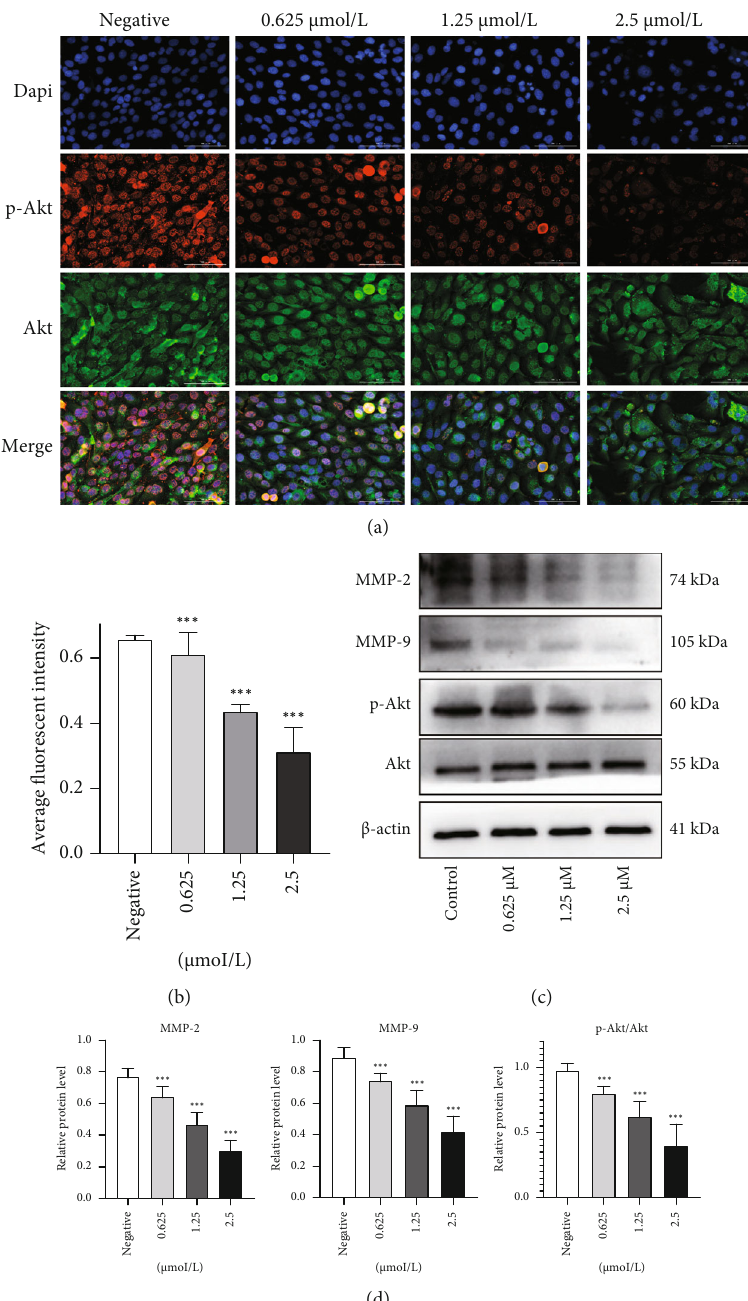
Figure 4: Anlotinib inhibits the migration of HSC-3 cells by suppressing the activation of the Akt pathway. (a) After HSC-3 cells were treated with di ff erent concentrations (0, 0.625, 1.25, and 2.5 μ M/L) of anlotinib for 24 h, expression of the p-Akt and Akt proteins was detected by immuno fl uorescence. (b) Quantitative immuno fl uorescence results of the p-Akt and Akt proteins. (c) HSC-3 cells were treated with anlotinib for 24 hours, and total MMP-2 and MMP-9, phosphorylated and total Akt and β -actin were detected by western blotting. (d) Ratio change of the migration markers MMP-2, MMP-9, phosphorylated, and total Akt. The data are expressed as the mean ± standard deviation of three repeats. ∗∗∗ P < 0 : 001 compared with the